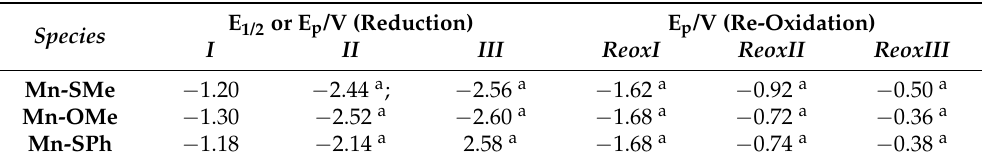
Table 1. Half-wave (E 1/2 ) and peak redox potentials (vs SCE) of compounds recorded in TBAH/DMF solution at 25 ◦